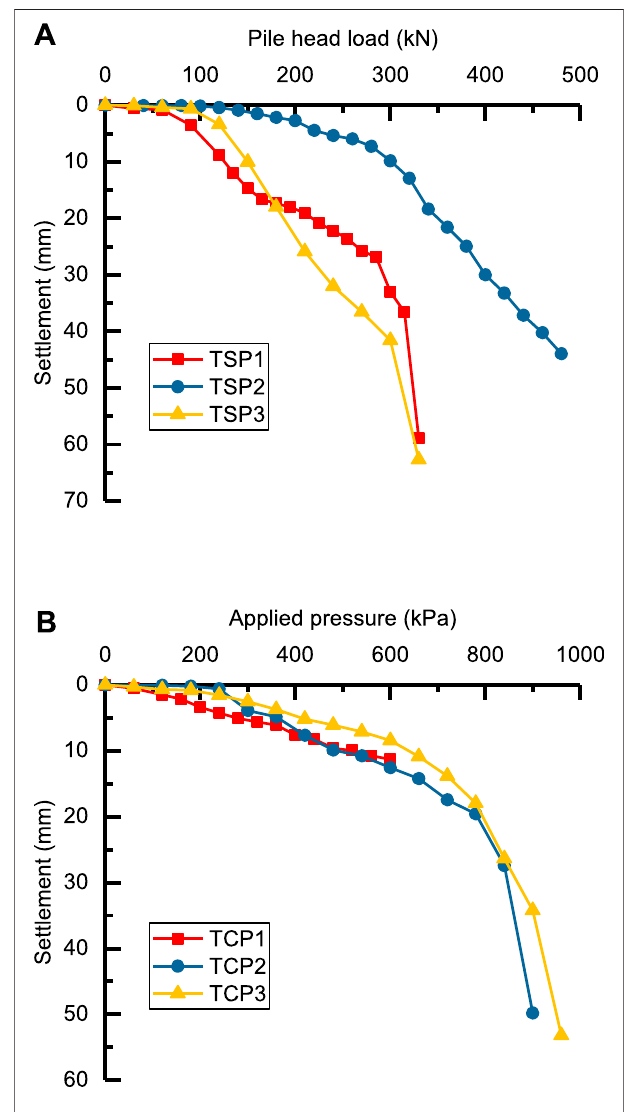
FIGURE 2 | Loading-settlement curves of (A) SPs and (B) CPs under static load test.